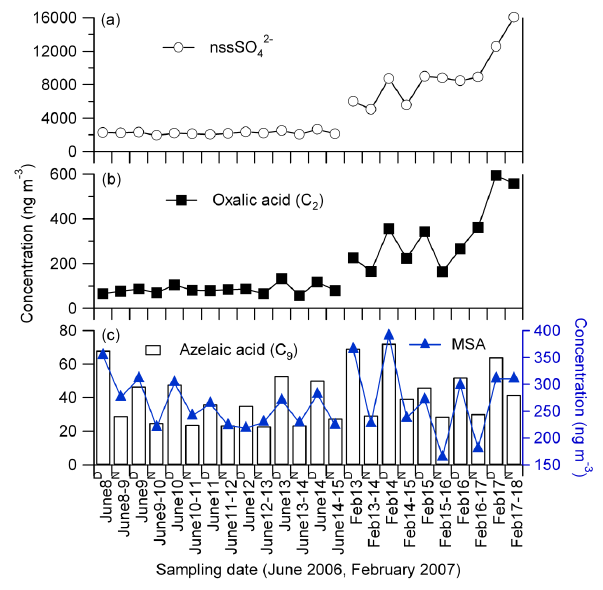
Fig. 4. Temporal variation in concentration of photochemical pro- duction tracers: (a) nssSO 2 − , (b) oxalic acid, and (c) marine source 4 tracers, i.e., azelaic acid and methanesulfonate.